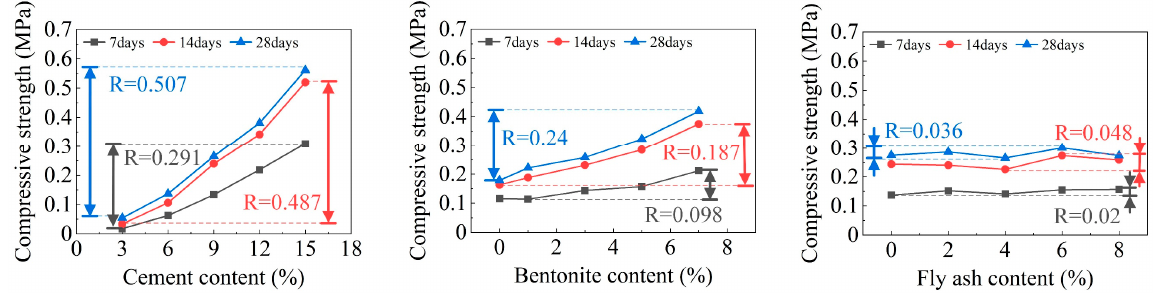
Figure 14. Range analysis of 7-, 14-, and 28-day compressive strengths.